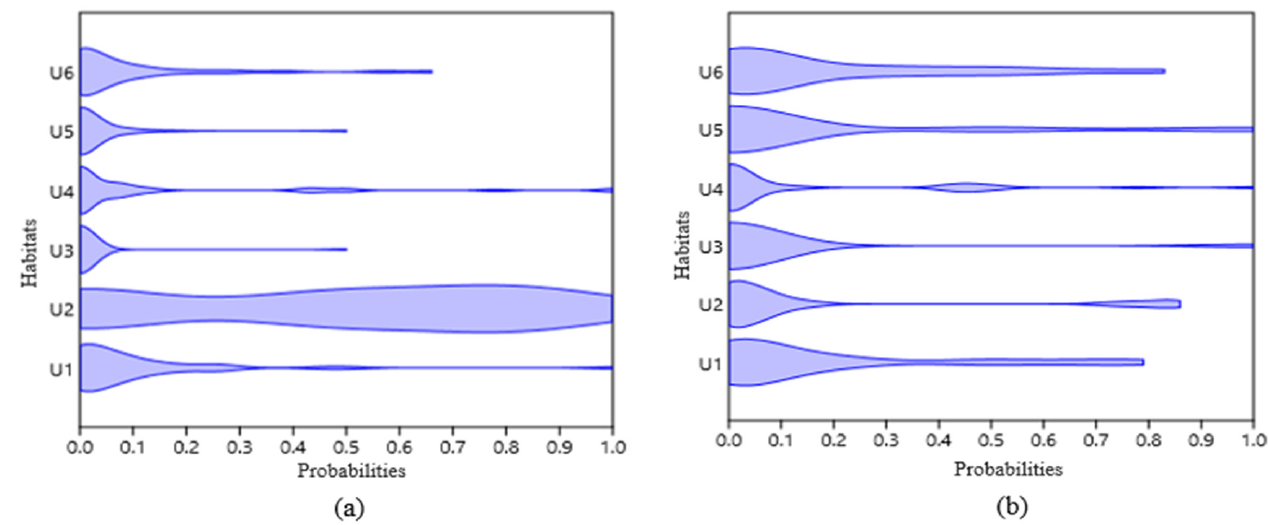
Figure 2. Profiles of the transition probabilities ( a ) incoming to and ( b ) outgoing from the current habitat (Table